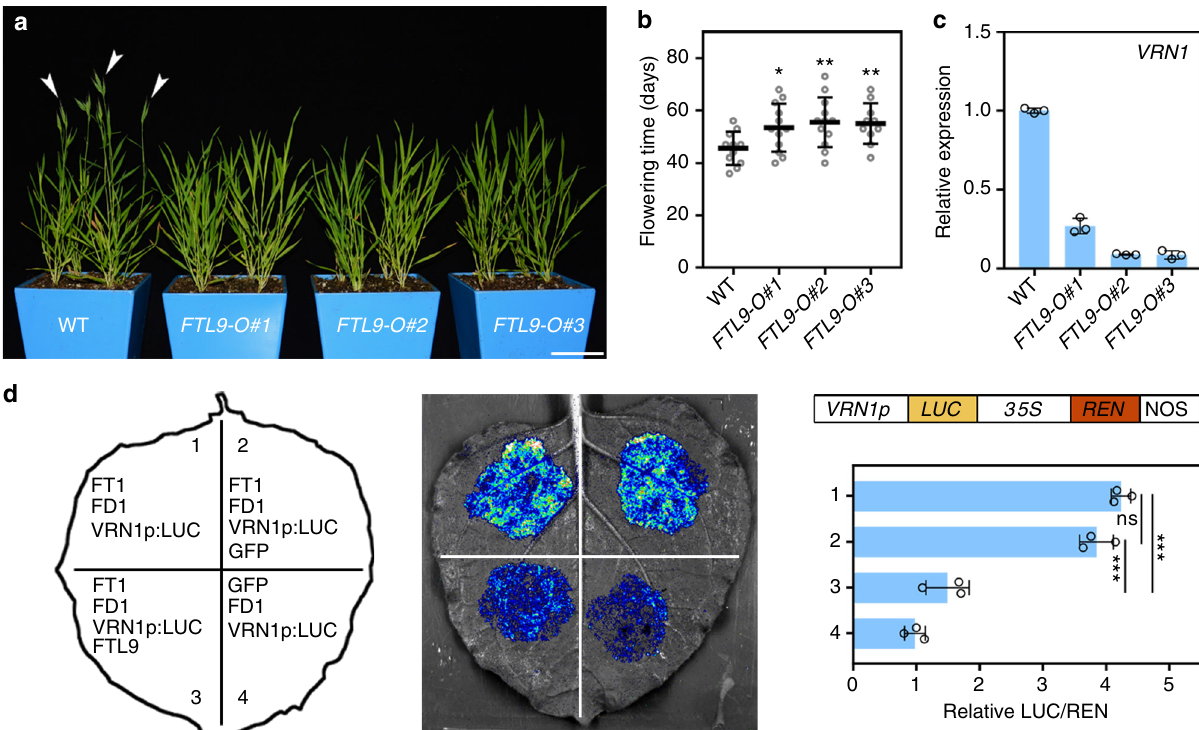
Fig. 4 Over-expression of FTL9 results in a fl owering delay under LDs in B. distachyon. a Representative phenotypes of three FTL9 over-expressing lines under LDs. White arrows point to spikes. Scale bar, 5 cm. b Flowering time of wild-type Bd21 and the FTL9-OE plants under LDs. At least 10 plants for each line were scored. (Student ’ s t test, ** P < 0.01, * P < 0.05). c qPCR analysis of fl owering downstream gene VRN1 expression in four-week-old wild-type and the FTL9-OE plants under LDs. Error bars indicate s.d. d FTL9 attenuates the binding ability of FT1-FAC to VRN1 cis-elements. Left: Different combinations of effectors and the reporter transiently introduced in N. benthamiana leaves. Middle: Representative photograph of fi re fl y luciferase fl uorescence signals when the indicated reporter and effectors were introduced in N. benthamiana leaves. Right: Relative reporter activity (LUC/REN) in N. benthamiana leaves expressing the indicated reporters and effectors. Error bars indicate s.d. (Student ’ s t test, *** P <